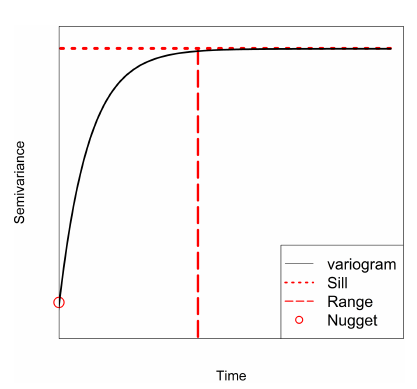
Figure 2. Theoretical